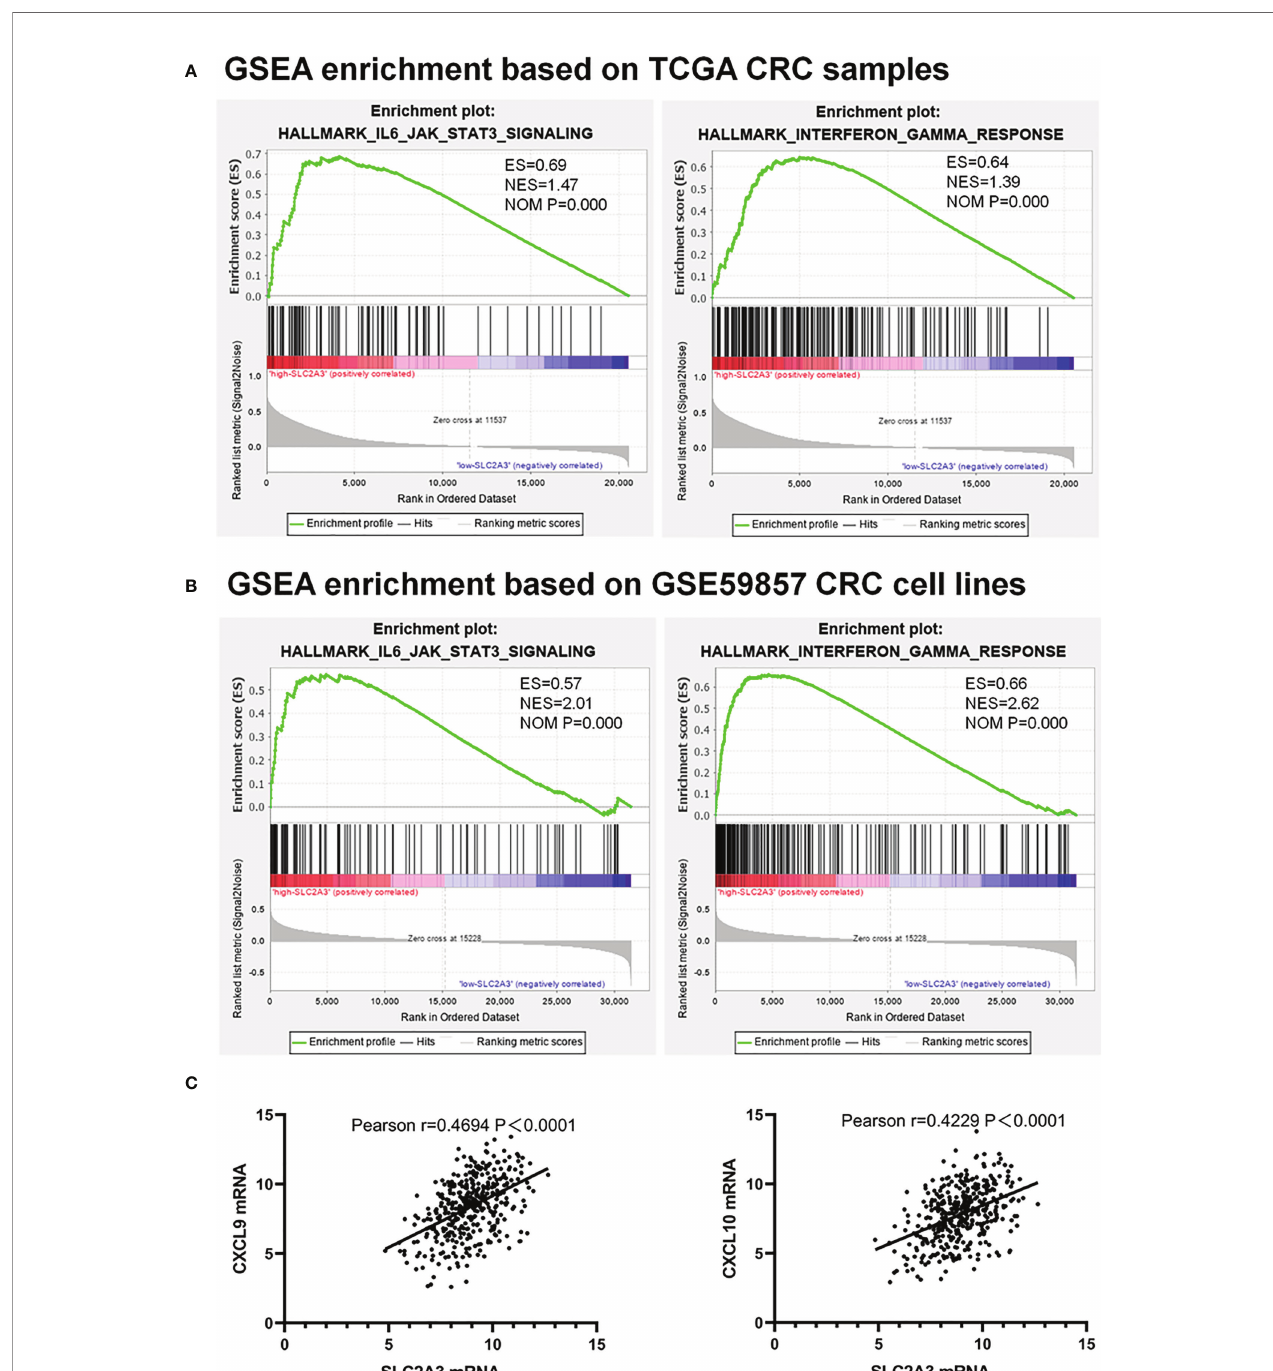
FIGURE 4 | SLC2A3 expression correlated with IL6/JAK/STAT3 signaling and interferon- g hallmark gene sets. (A) TCGA database, (B) GSE59857 database, (C) the positive correlation between SLC2A3 expression and CXCL9 and CXCL10 expression based on